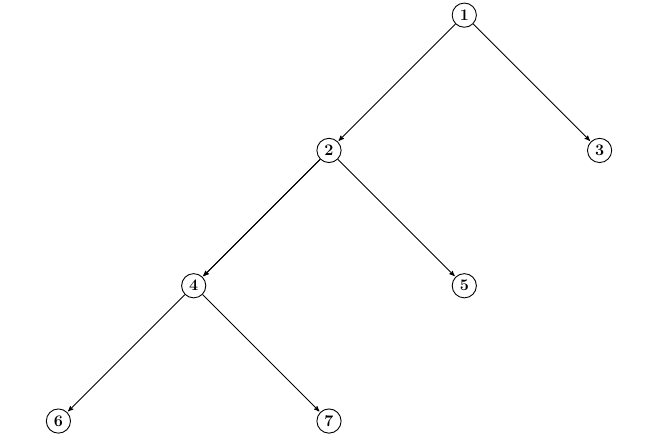
Figure 6: Tree structure ( a